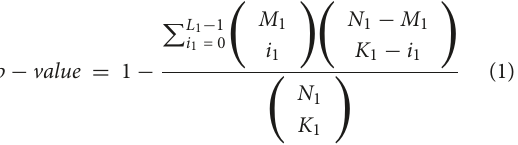
network connectivity score (Z score < − 2) (Oldham et al.,